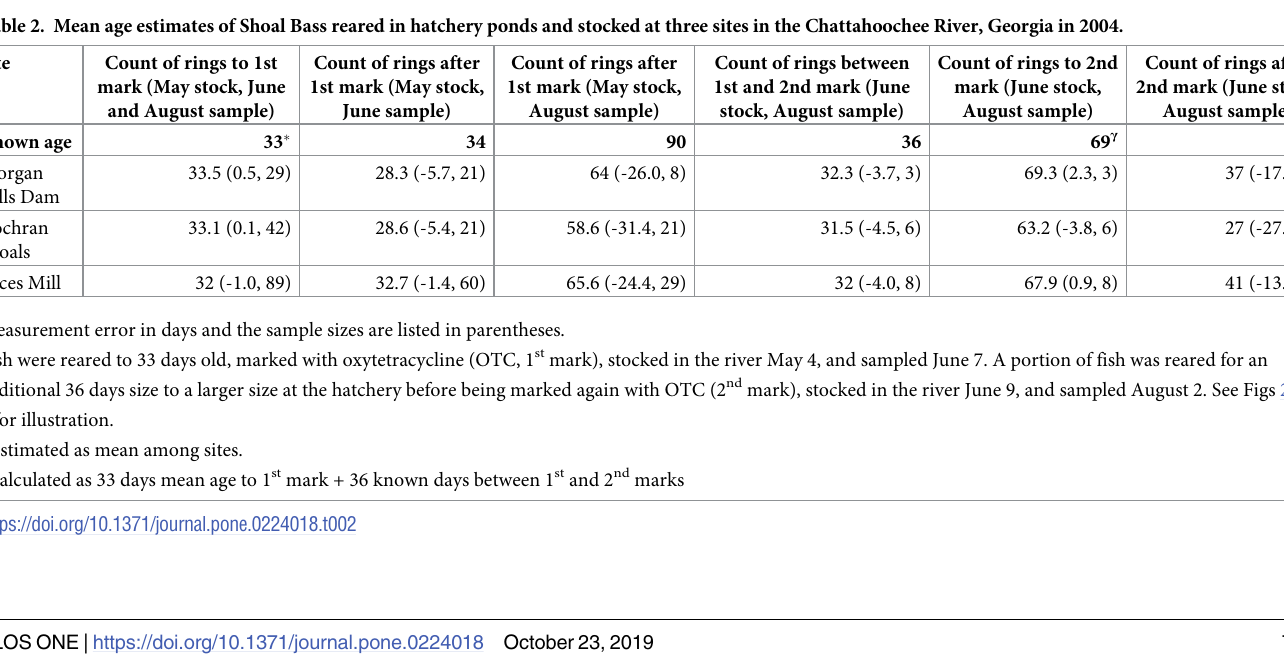
TL, total length, MFD, Morgan Falls Dam, CS, Cochran Shoals, and PM, Paces Mill. Fish were reared to 33 days old, marked with oxytetracycline (OTC, 1 st mark), stocked in the river May 4, and sampled June 7. A portion of fish was reared for an additional 36 days size to a larger size at the hatchery before being marked again with OTC (2 nd mark), stocked in the river June 9, and sampled August 2. See Fig 1 for location of sites in the river and Fig 2 for illustration of OTC marks on otoliths.